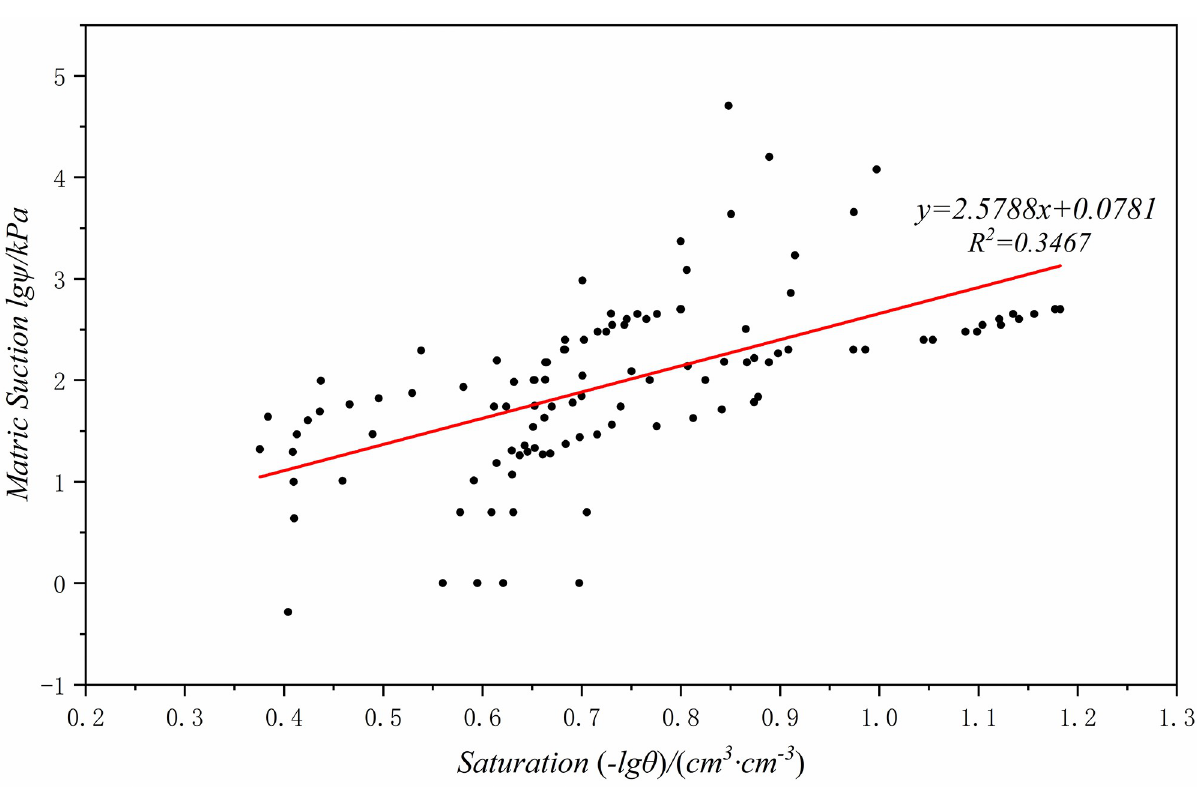
Fig 7. Sandy loess (Zone I) degree of saturation and matric suction fitting result.